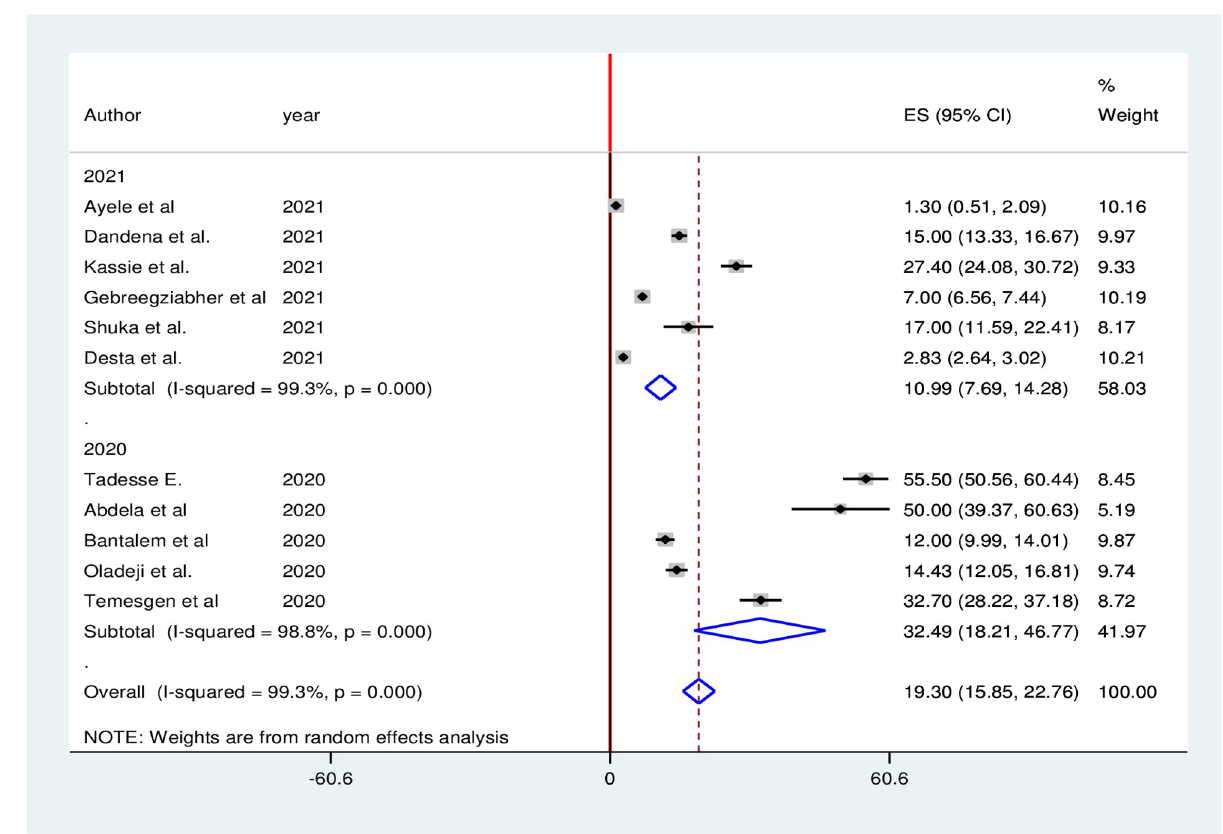
Fig 6. Subgroup analysis of antenatal care services reduction during the COVID-19 pandemic in Ethiopia, 2021.